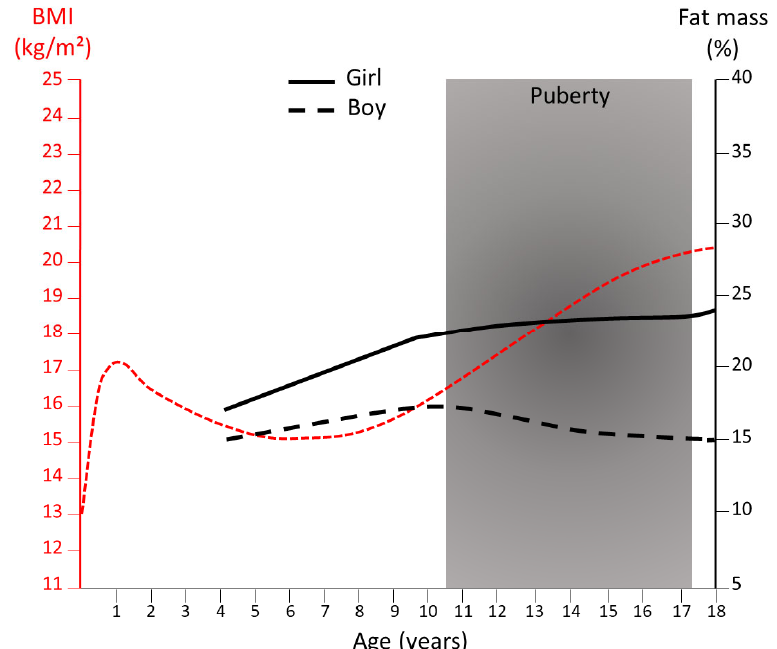
Figure 1. Evolution of body mass index and fat mass percentage from childhood to early adulthood. The body mass index (BMI) curve (in red) is extracted from the 50th percentile in boys and girls from IOTF (International Obesity Task Force) and the % body fat from the 50th percentiles of body fat reference curves for boys (dotted black line) and girls (solid black line) [19].